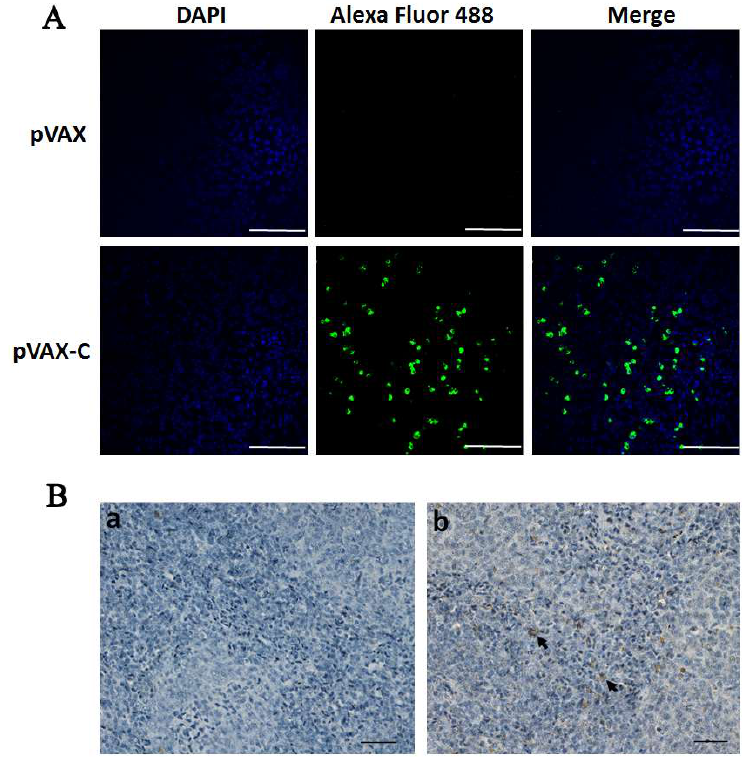
Figure 2. Expression of the capsid protein gene in vitro and in vivo. ( A ) COS7 cells were transfected with the DNA vaccine plasmids pVAX-C or pVAX. At 48 h post transfection, the cells were processed by indirect immunofluorescence assay using the anti-DTMUV-capsid protein rabbit polyclonal antibody as the first antibody and the Alexa Fluor 488-conjugated (green fluorescence) goat anti-rabbit as the secondary antibody. Scale bar 200 μm; ( B ) Spleens collected from the SL7207 (pVAX) ( a ) or the SL7207 (pVAX-C) vaccination group ( b ) at 3 dpi ( n = 3). The capsid protein was detected by immunohistochemistry assay using the anti-DTMUV-capsid protein rabbit polyclonal antibody as the primary antibody and the horseradish peroxidase-conjugated goat anti-rabbit secondary antibody. The brown dots directed by the arrow indicated the capsid protein. Scale bar 50 µ